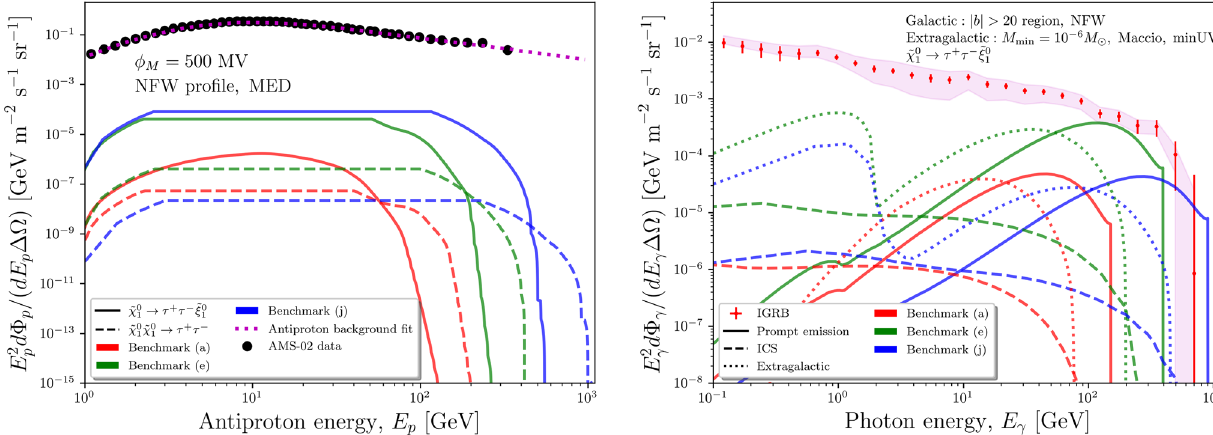
Fig. 3 Left panel: contributions from the annihilation and decay of the MSSM neutralino ˜ χ 0 to the antiproton flux for three of the benchmarks 1 of Table 1. The antiproton background and AMS data are also shown. Right panel: the gamma ray flux from the IGRB (for decay only) show-